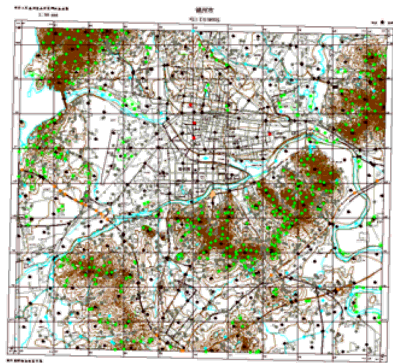
Figure 6. The thumbnail image of the digital topographic map